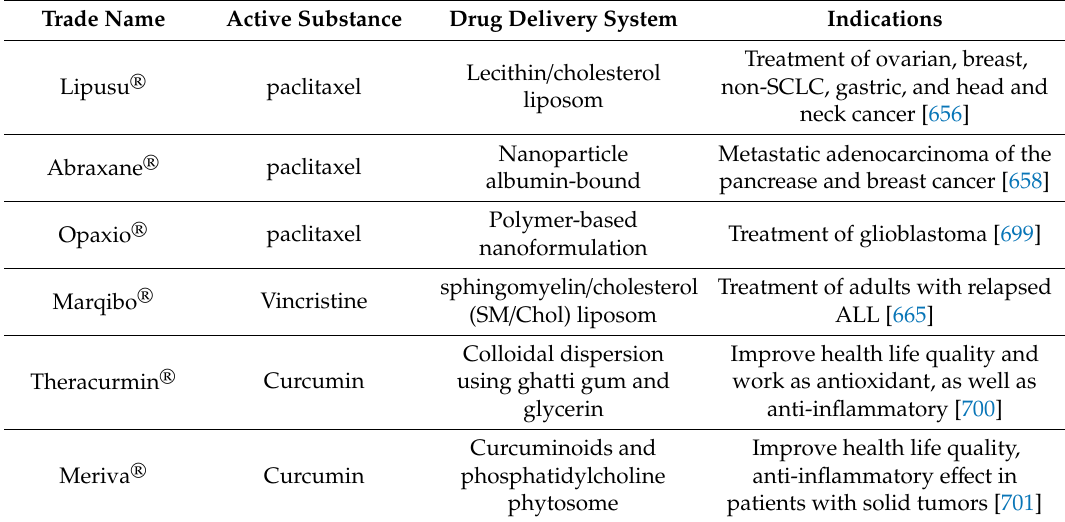
Table 2. Commercially approved target delivery systems and their active